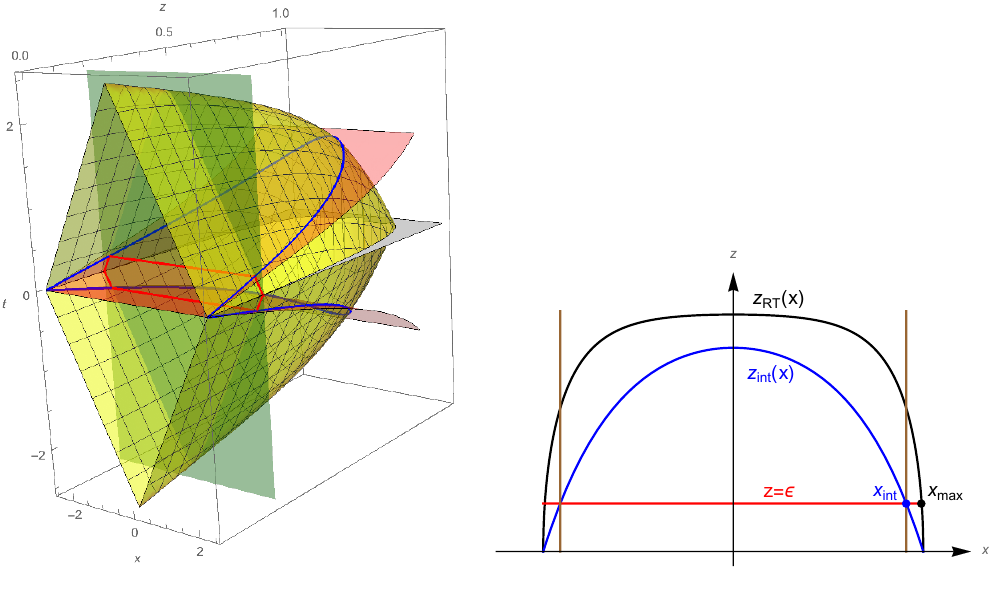
Figure 7 . Another regularization for the BTZ